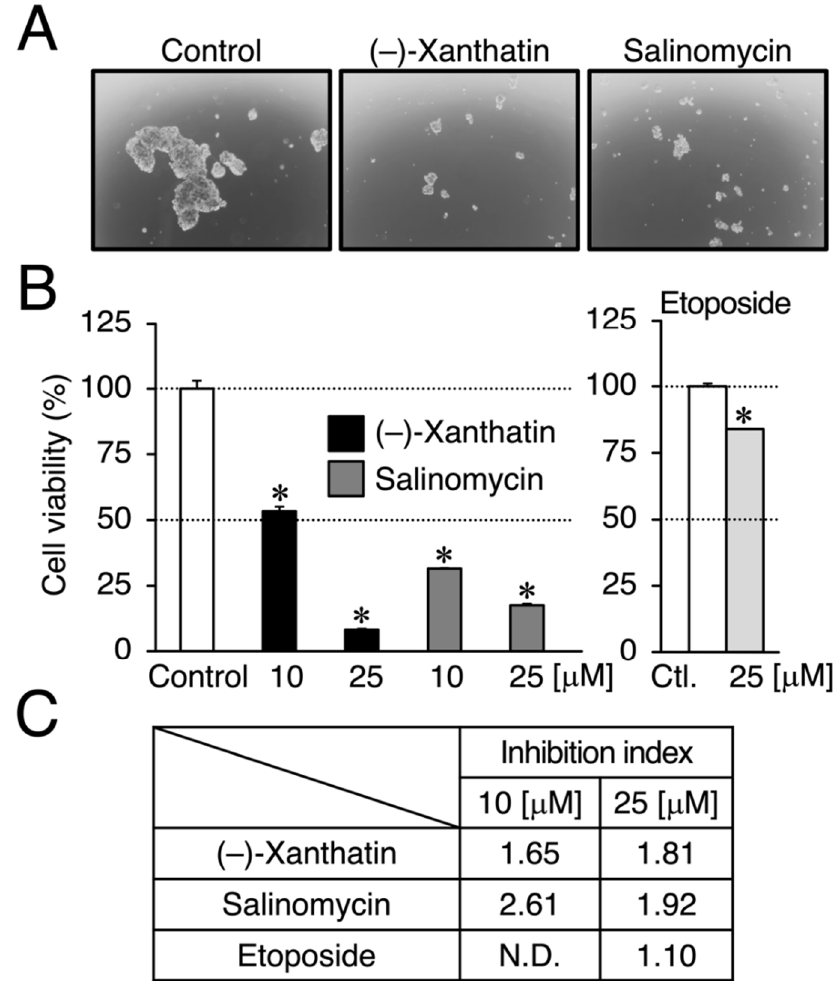
Figure 2. (–)-Xanthatin- and salinomycin-mediated suppression of the viability of mammospheres derived from MCF-7 cells. ( A ) Morphology of mammospheres treated with vehicle, 25 µ M (–)-xanthatin, or 25 µ M salinomycin for 72 h is shown (representative image). The images were taken at × 40 magnification. ( B ) Mammospheres were treated with vehicle, (–)-xanthatin (10 and 25 µ M), salinomycin (10 and 25 µ M) ( left panels), or etoposide (25 µ M) ( right panel) for 72 h, and cell viability was assessed. Data are presented as the mean ± S.E. ( n = 3) percentage of the vehicle-treated control. ( C ) The inhibition index, which is a ratio (%) of the viability between MCF-7 cells and mammospheres at the indicated concentrations of chemicals, is shown. When the inhibition index is greater than 1.0, the chemical exhibits the targeted abrogation of the viability of mammospheres. * Significant differences ( p < 0.05) from the vehicle-treated control. N.D., not determined.